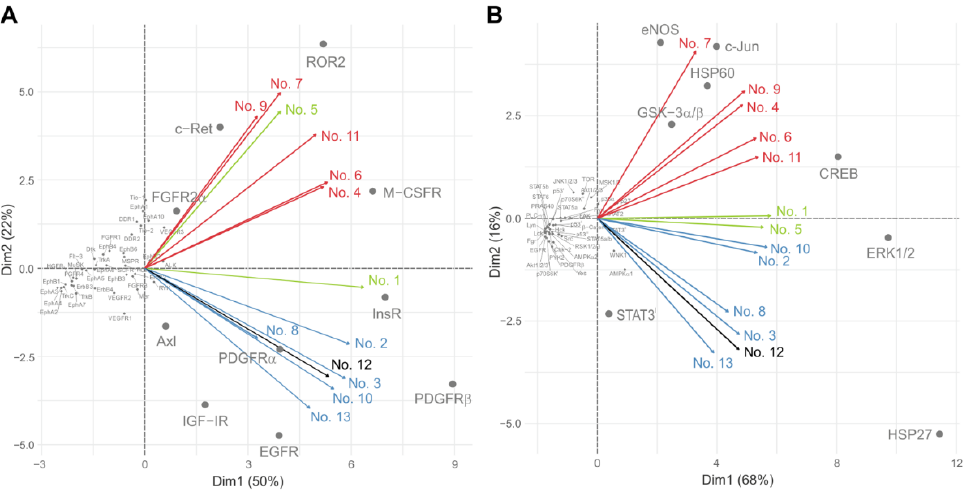
Figure 3. PCA of data determined for RTKs ( A ) and downstream kinases ( B ). Red vectors: samples from patients not treated with denosumab (Nos. 4, 6, 7, 9 and 11); blue vectors: samples from pa- tients obtained immediately after denosumab treatment (Nos. 2, 3, 8, 10 and 13); green vectors: samples from relapsed denosumab-treated patients (Nos. 1 and 5); black vector: sample from pa- tient treated with denosumab and sunitinib simultaneously (No.